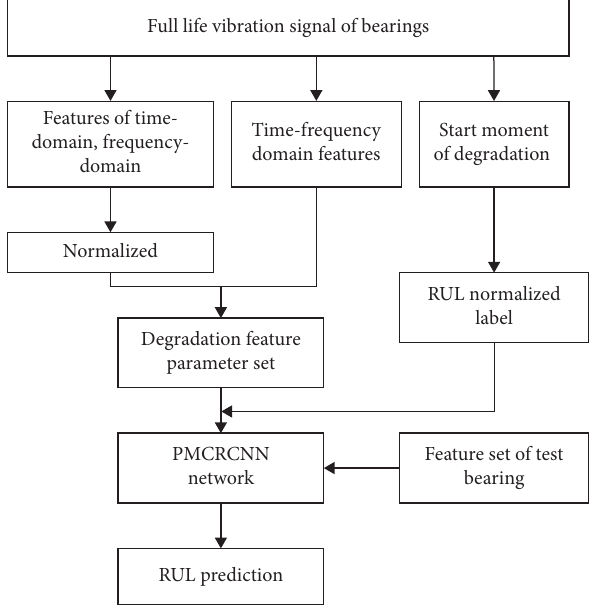
Figure 4: Flowchart of the proposed